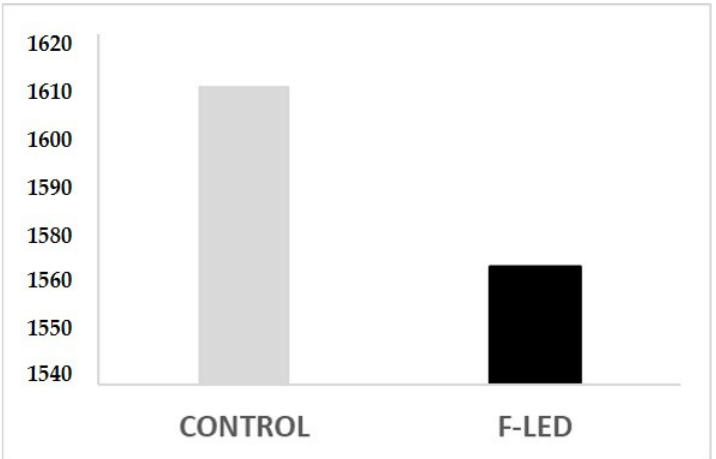
Figure 2 . Feed conversion rate of the two groups of chicken obtained at the end of the trial . Figure 2. Feed conversion rate of the two groups of chicken obtained at the end of the